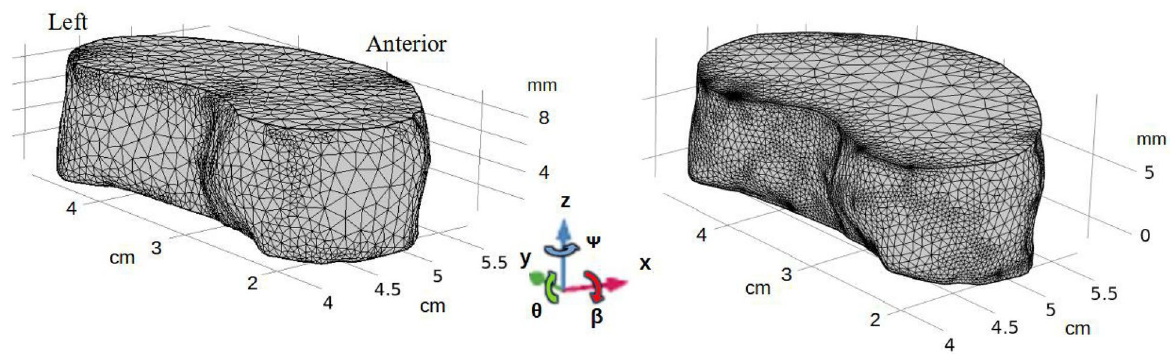
Figure 1. Two models of the intervertebral disc with their final mesh: initial geometry (left) and modified geometry (right). x axis points anteriorly, y points left and z points